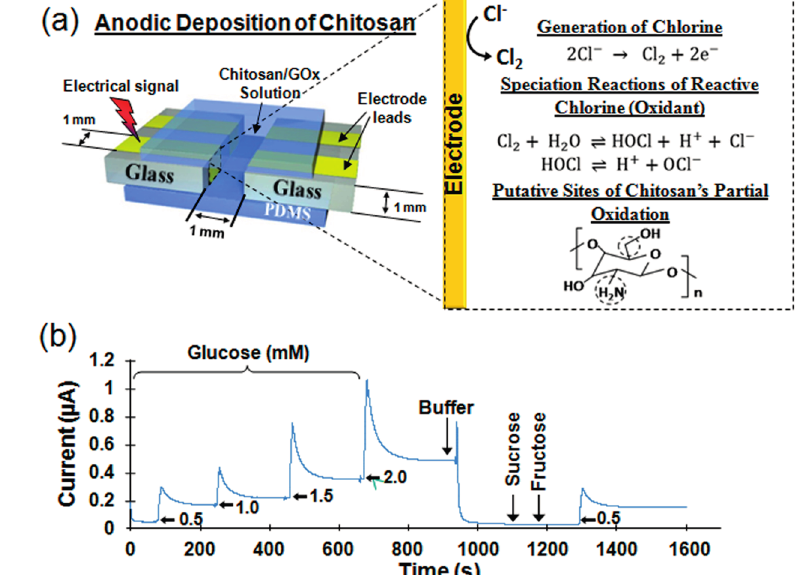
Figure 11. Anodic deposition of chitosan results from a sequence of chemical reactions that results in a covalently crosslinked network and possibly with covalently conjugated proteins. ( a ) Proposed deposition mechanism; ( b ) Results with the model biosensing enzyme glucose oxidase (GOx). Reproduced with permission from [131], published by American Chemical Society,